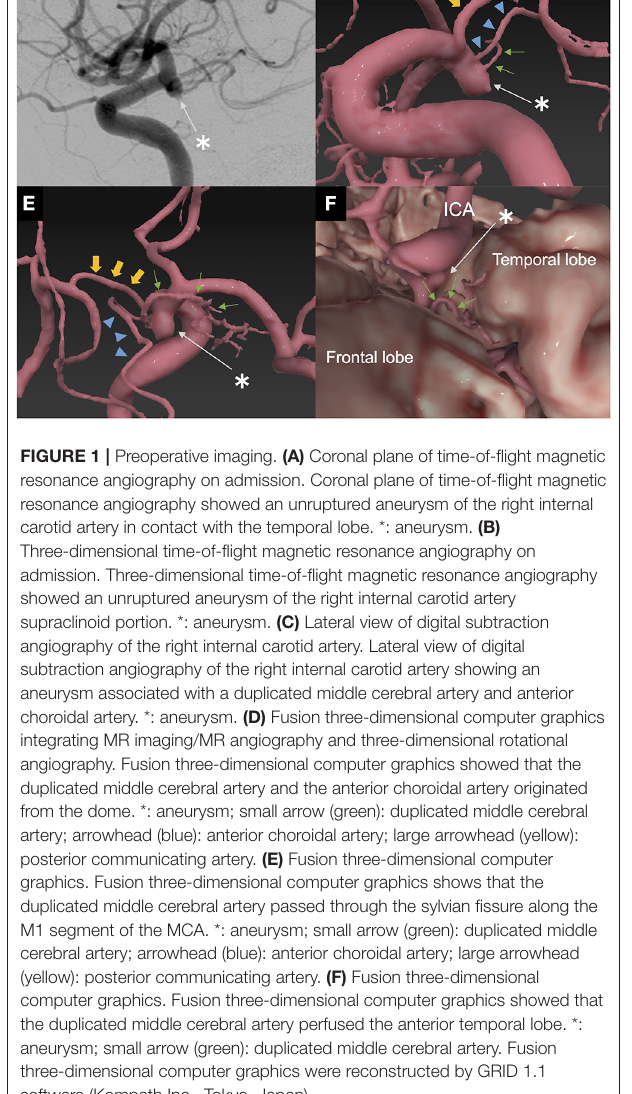
The incidence of DMCA ranges from 0.7 to 2.9% (9, 10). The DMCA arises between the origin of the AChA and the distal end of the ICA. Both the AChA and MCA originate from the earlier than the MCA (11). Komiyama et al. (1) described